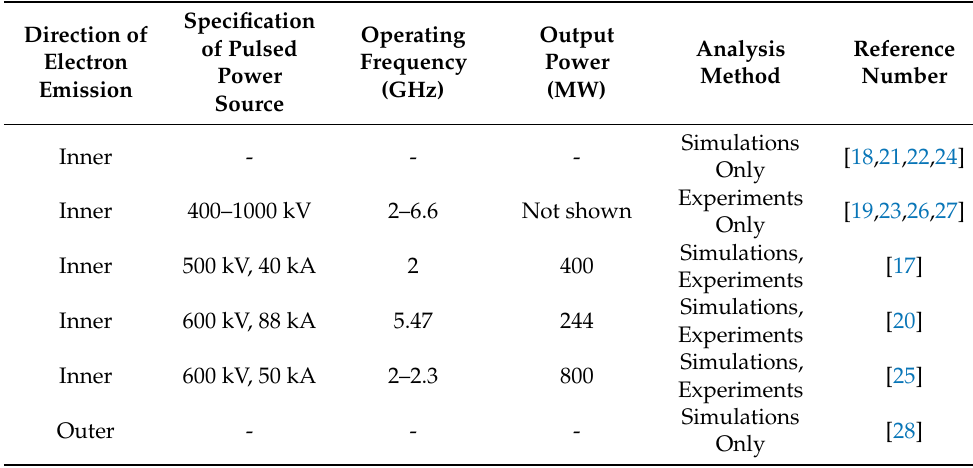
Table 1. Summarization of other works on the coaxial